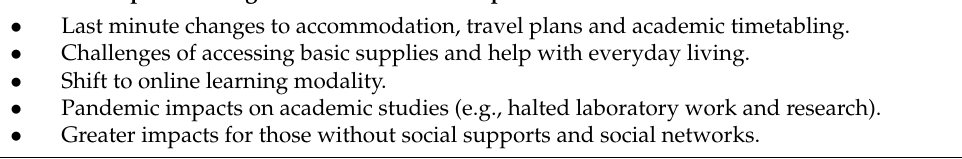
Table 3. Key points and policy